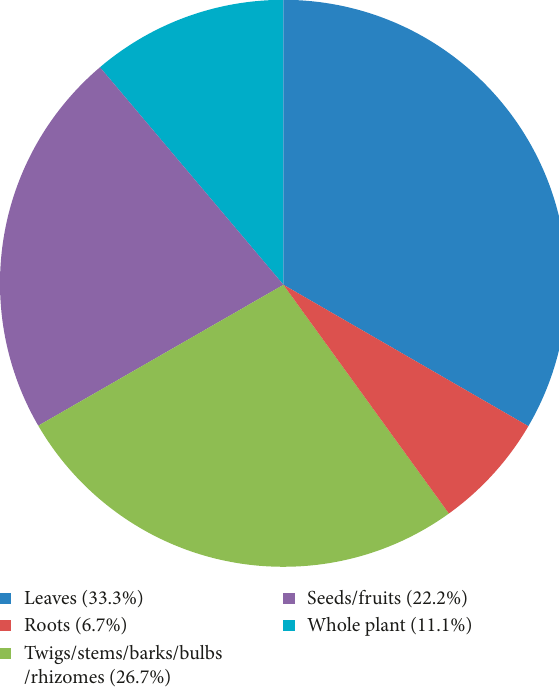
Figure 3: Plant parts used in herbal preparations.